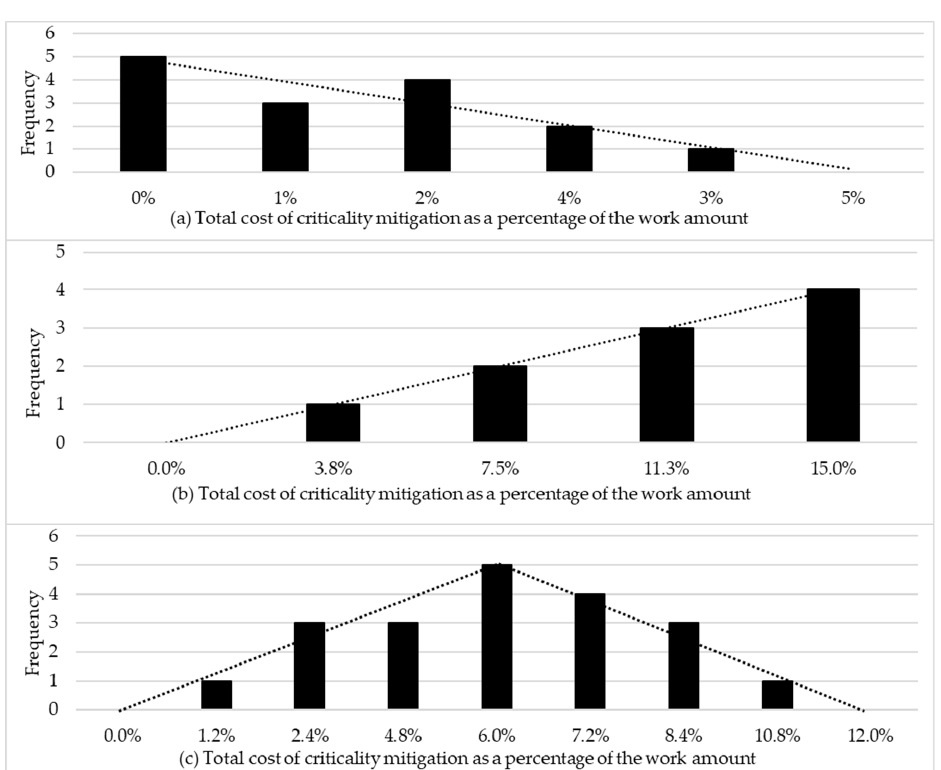
Figure 2. Graphs that relate the total cost of mitigating the criticality of the Superbonus expressed as a percentage of the amount of work and the frequency with which they occur for each project of the three datasets: ( a ) Dataset consisting of 15 projects carried out on small buildings (single-family and two-family); ( b ) dataset consisting of 10 projects carried out on multi-family buildings started before the introduction of CILAS; ( c ) dataset composed of 21 projects carried out on multi-family buildings following the introduction of CILAS. Subsequently, again starting with the data in Tables 5–7, for the three groups of projects, it was possible to identify the percentages of the minimum, maximum, and most recurring costs for each critical component to be mitigated (see Table 8). Table 8. Minimum, maximum, and more frequent costs of mitigation of urban planning, technical, and administrative criticalities, as a percentage of the cost of the efficiency intervention, in the case of small buildings (single-family and two-family), multi-family buildings whose projects started before the introduction of CILAS, and multi-family buildings whose projects started after the introduction of CILAS.